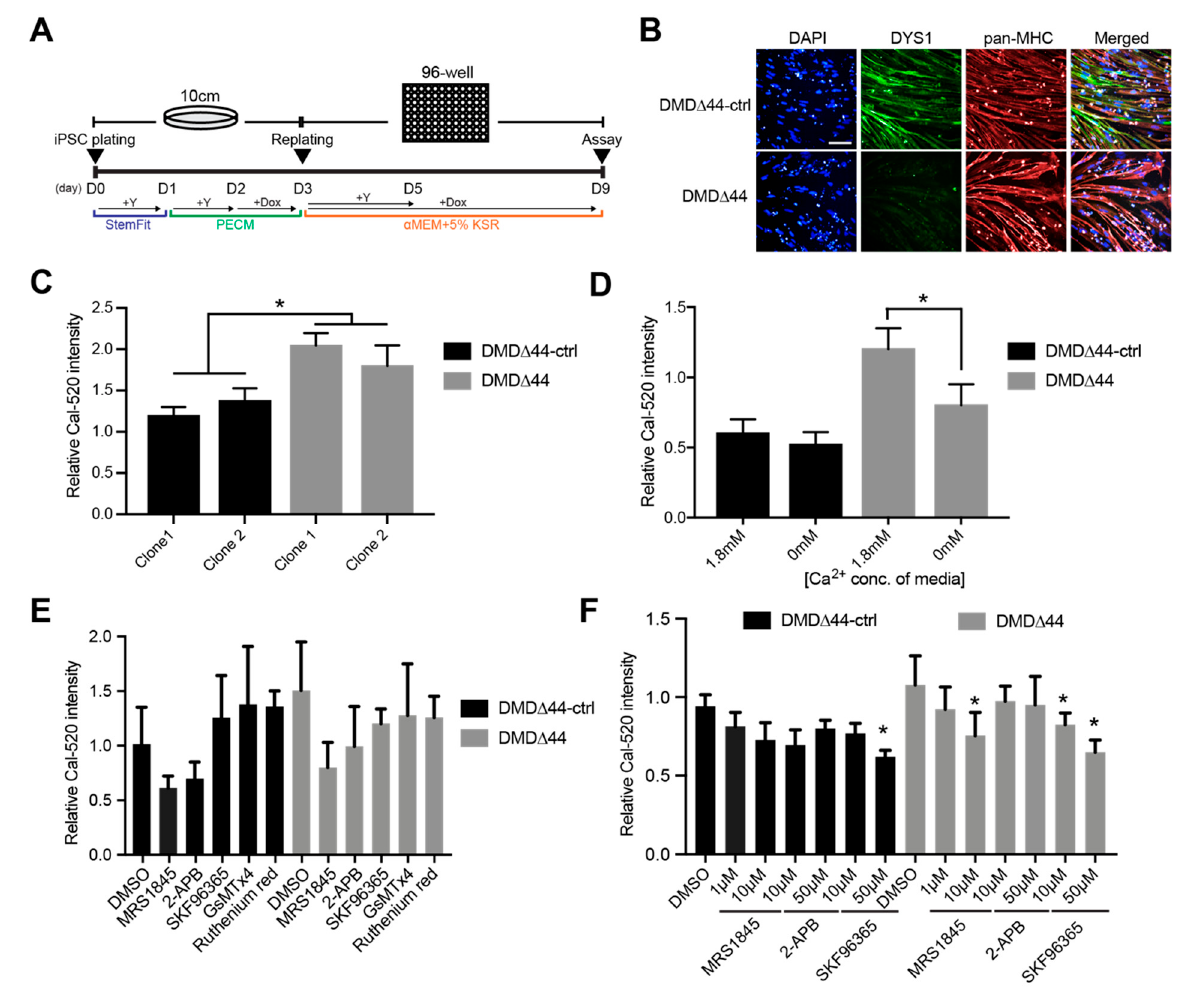
Figure 1. Store-operated Ca 2+ channels (SOCs) regulate Ca 2+ overload in dystrophic myotubes using induced pluripotent stem cells (iPSCs). ( A ) A schematic diagram of the standard replating method. The iPSCs (DMD ∆ 44 and DMD ∆ 44-ctrl) were myogenically pre-differentiated in primate ES cell medium (PECM) in the presence of doxycycline and re-plated on day 3 in the presence of Y-27632 and doxycycline in 5% knockout serum replacement (KSR) media. ( B ) Immunocytochemical analysis of DYS1 and pan-MHC in differentiated myotubes on day 9. Scale bar = 200 µ m. ( C – F ) Relative Ca 2+ concentration using DMD ∆ 44-ctrl and DMD ∆ 44 cell lines and ( D ) Ca 2+ -free media, ( E ) Ca 2+ channel inhibitors, and ( F ) SOC inhibitors. * indicates p < 0.05. Y = Y-27632, Dox = doxycycline, Conc. = concentration.